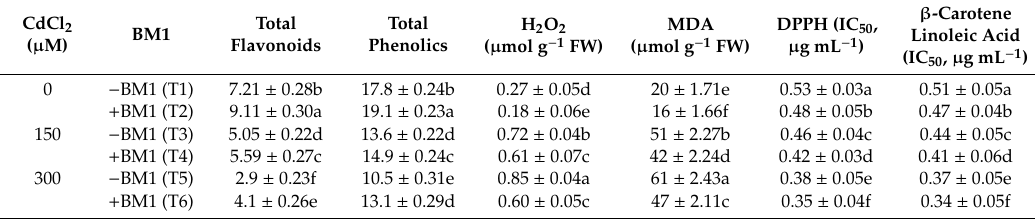
Table 4. The hydrogen peroxide (H 2 O 2 ) content, lipid peroxidation (MDA) level, total flavonoid content (mg catechin / g extract), total phenolic content (mg gallic acid / g extract) and antioxidant activity (DPPH and β -carotene-linoleic acid) of leaves of un-inoculated and inoculated soybean plants with Serratia marcescens BM1 under Cd